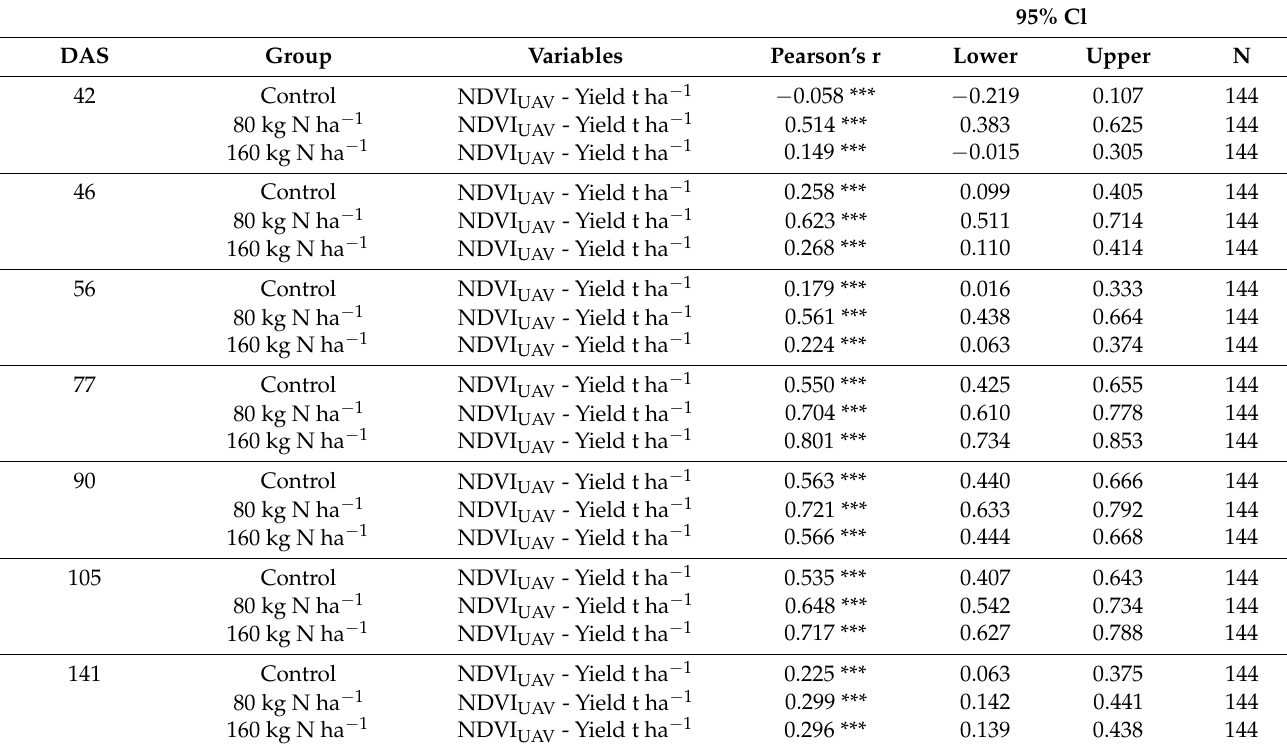
Table 6. Pearson correlation coefficient (r) values among NDVI UAV and yield t ha − 1 as a result of N ha − 1 fertilization (2021, Debrecen).